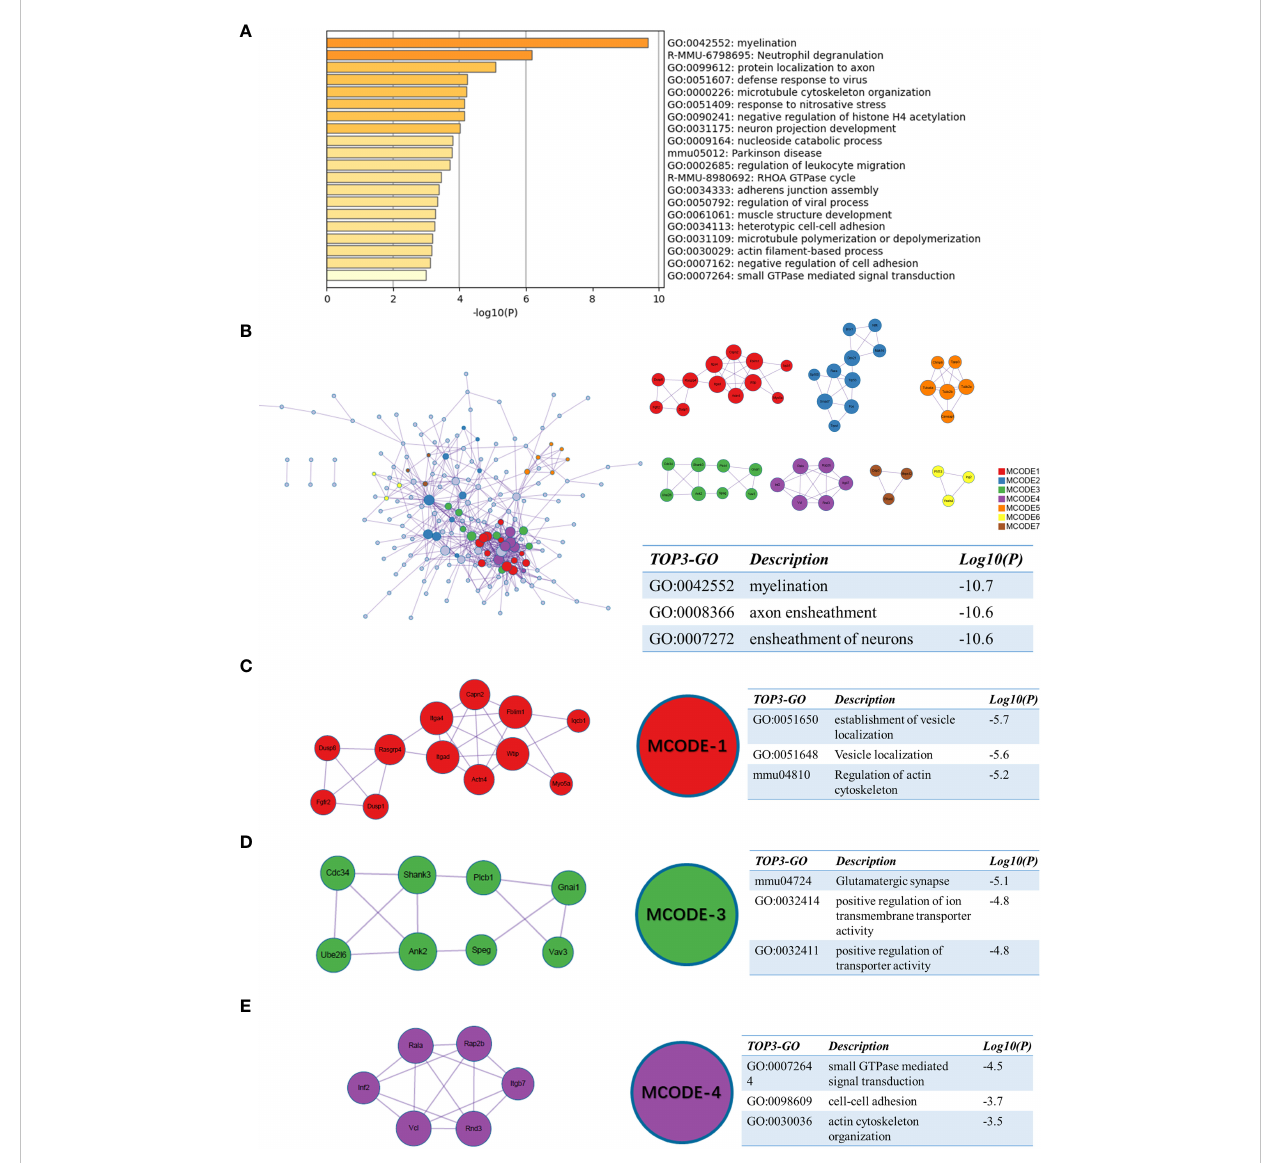
FIGURE 7 Functional enrichment of the sc_S3 on day 7 after tMCAO. (A) The top 20 enriched terms of the sc_S3 on day 7 by Metascape, colored by p-values. (B) Protein-protein interaction network and all MCODE components identi fi ed of the sc_S3 on day 7. (C – E) Representative MCODEs with correlation to enrichment analysis of the